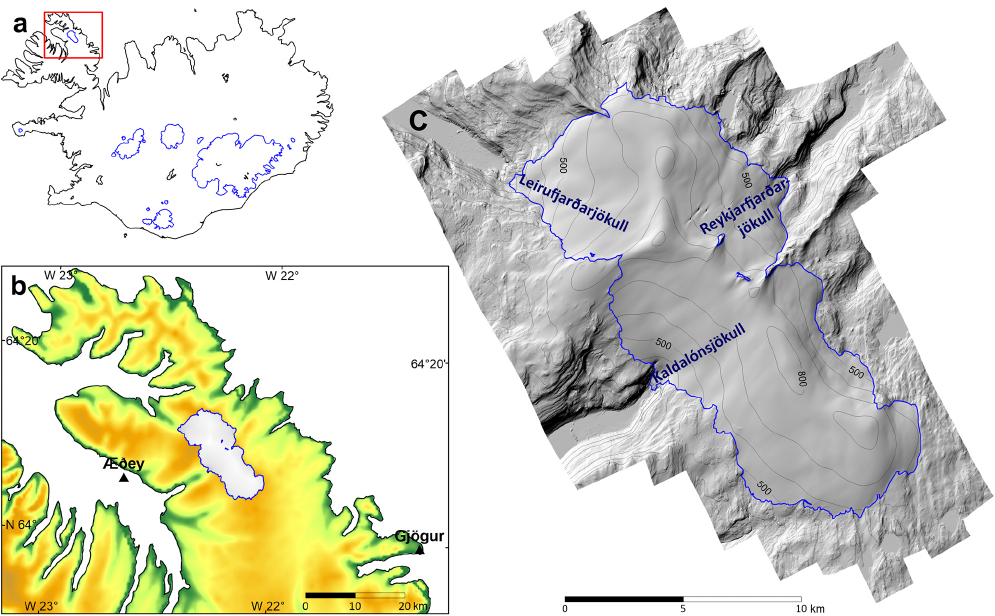
Figure 1. Location of study area. Blue lines in (a) are the outline of the larger glaciated areas in Iceland. The triangles in (b) indicates the locations of the meteorological stations at Æðey and Gjögur. Image (c) shows a lidar DEM of Drangajökull (glacier margin shown with blue line) and vicinity obtained in 2011 (Jóhannesson et al., 2013) represented as shaded relief image and contour map (100m contour interval). The names and locations of the three main outlet glaciers are shown. Table 1. Dates, main parameters and notes describing the data sets used in the